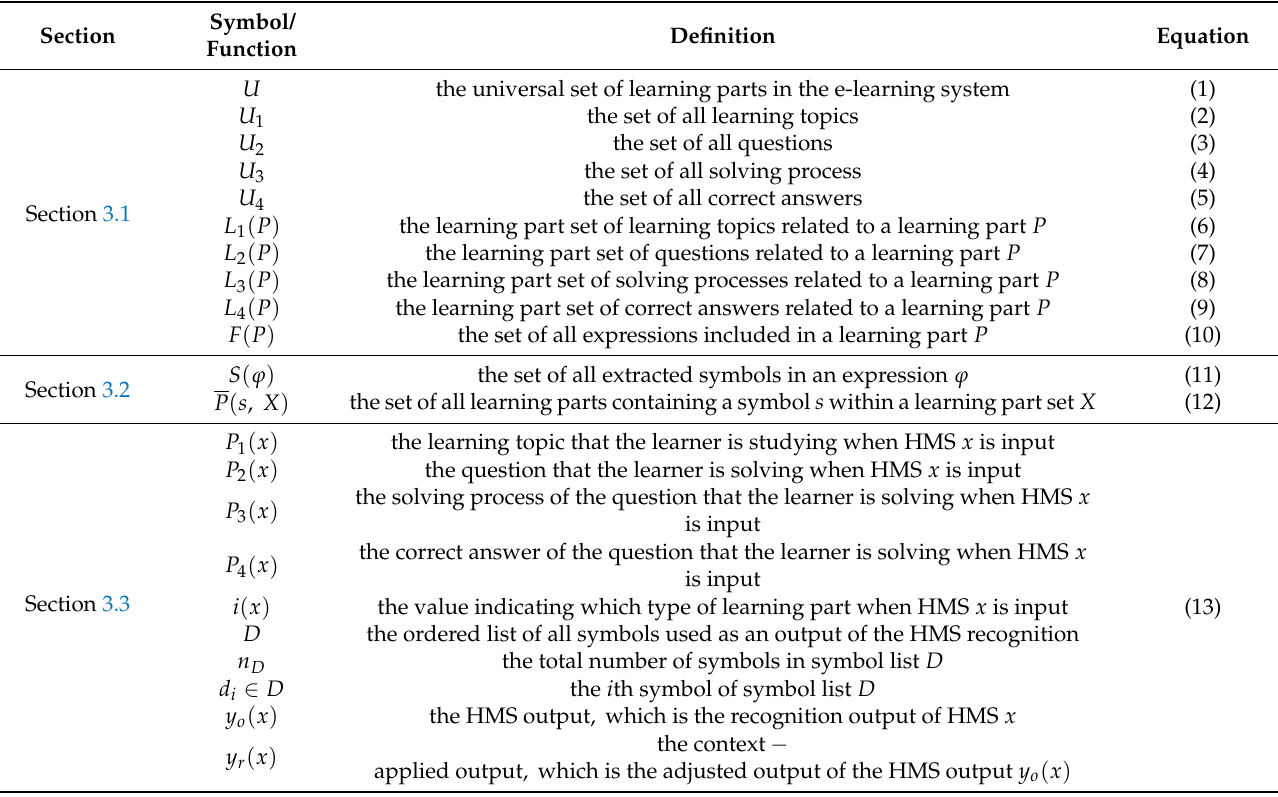
Table A1. Definitions of Symbols and Functions in Section